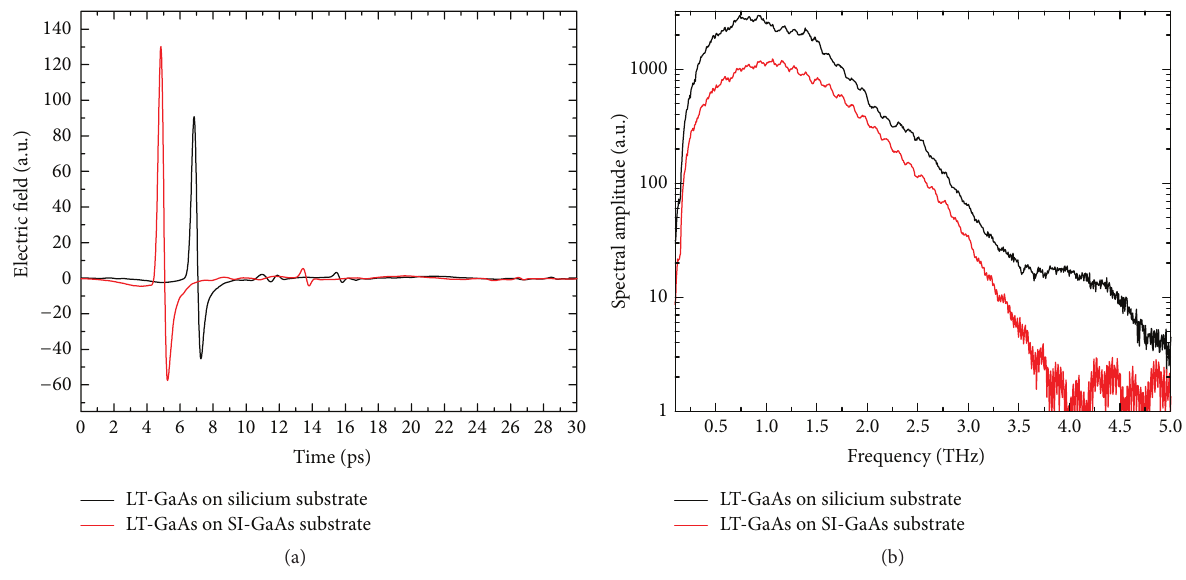
Figure 6: Measured waveforms (a) and corresponding spectrum (b) using Si or SI-GaAs